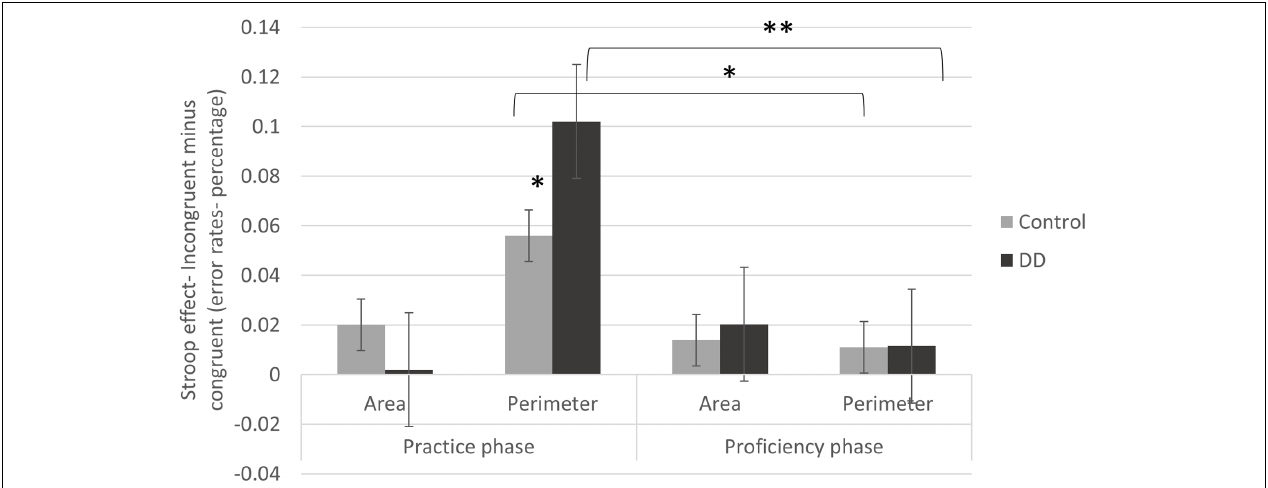
FIGURE 3 | Stroop effects (incongruent minus congruent trials) on error rates (in percentage) of practice and proficiency phases in both groups (DD and Control). Error bars depict ± 1 SE of the mean. Significance values: ∗ p < 0.05, ∗∗ p < 0.01.